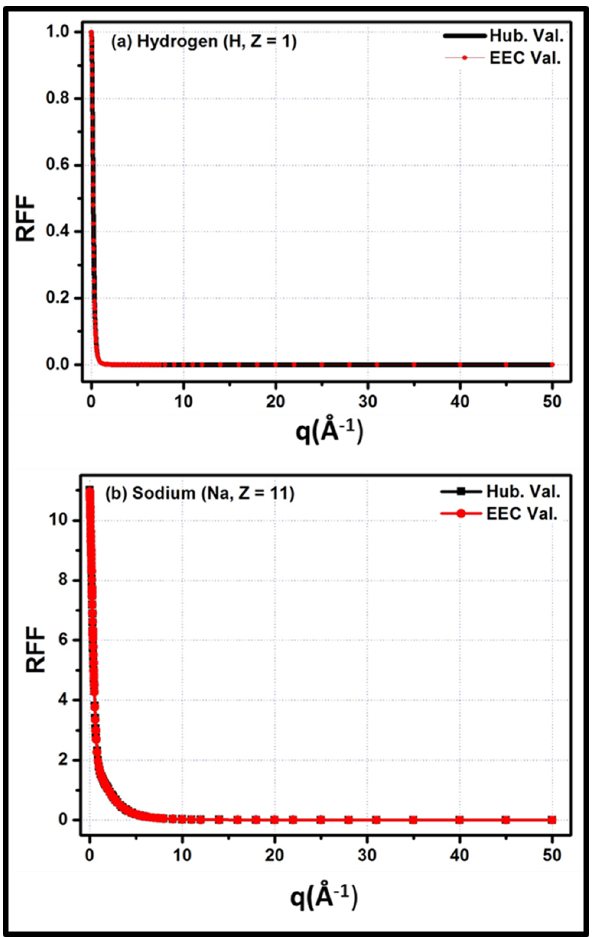
Figure 2. Fitting of the F H ( q i , Z ) function in the momentum transfer range, q=0–50 A˚ 2 1 for (a) Silicon (Si, Z=14) (b) Manganese (Mn, Z=25). Here, Hub. Val. Indicates F H ( q i , Z ) and EEC val. indicates Empirical Equation Calculated